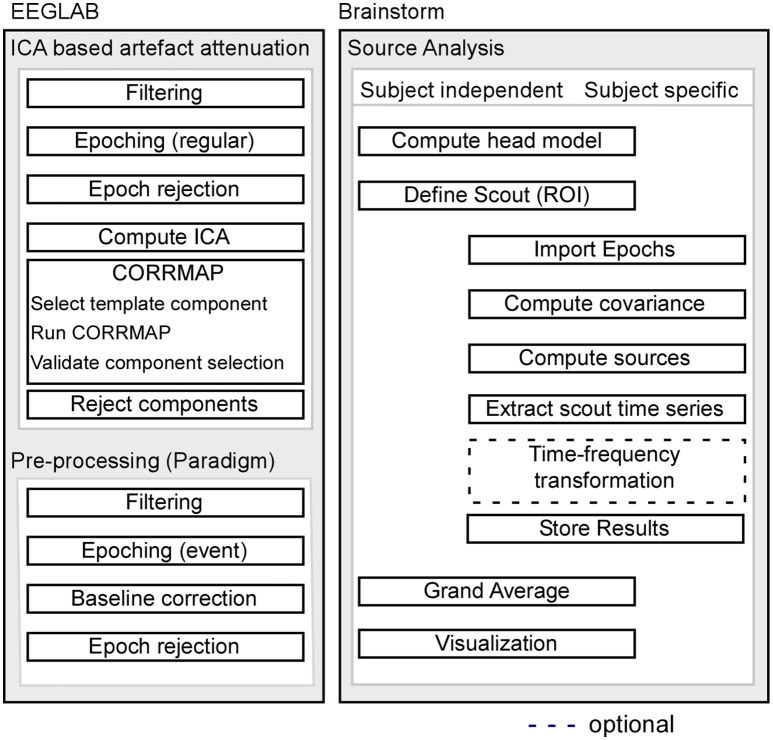
Schematic illustration of the processing pipeline. The dashed line indicates that alternative processing steps are possible, but are not implemented in the current pipeline. EEG pre-processing using EEGLAB is shown on the left, while source analysis implemented in Brainstorm is shown on the right.